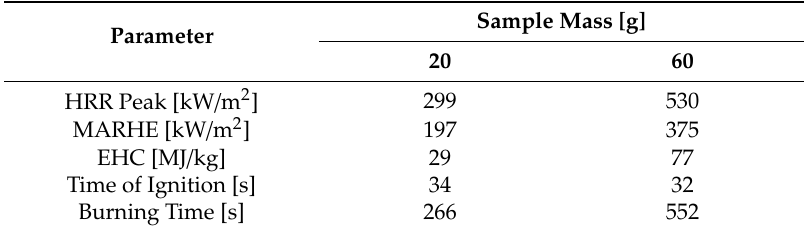
Table 3. Comparison of combustion parameters of PA 6 with di ff erent mass.